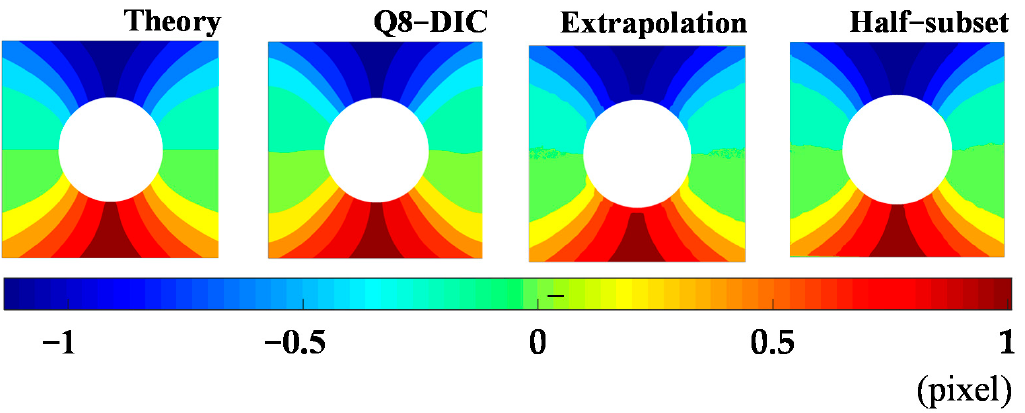
Figure 7. Displacement fields obtained by different